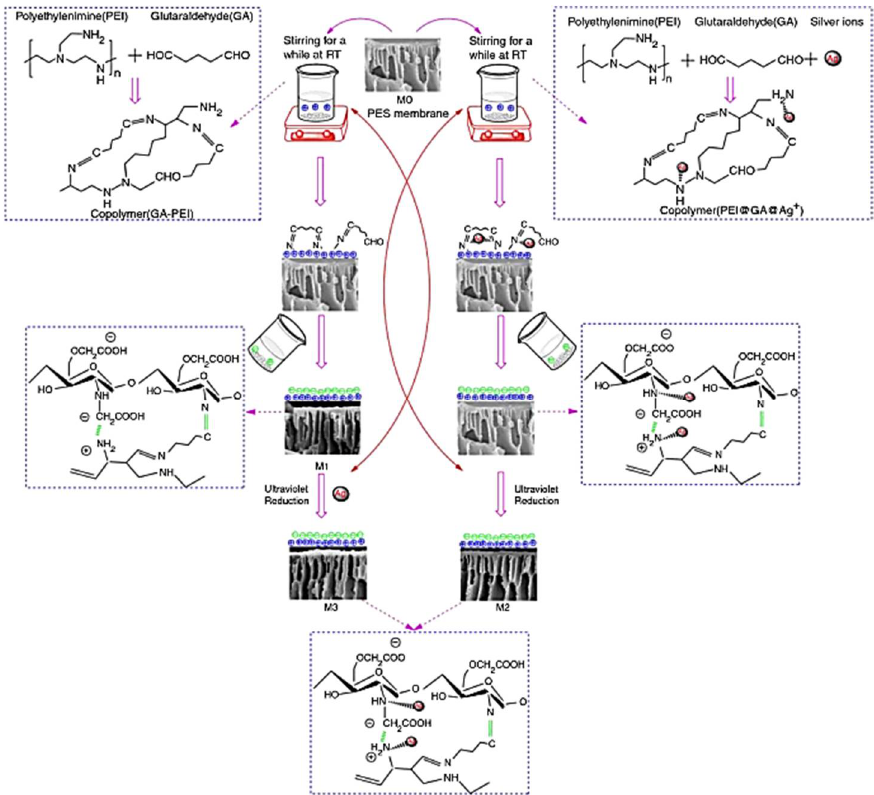
Figure 9. Schematic diagram of the preparation process and mechanism for the composite mem- brane [74].